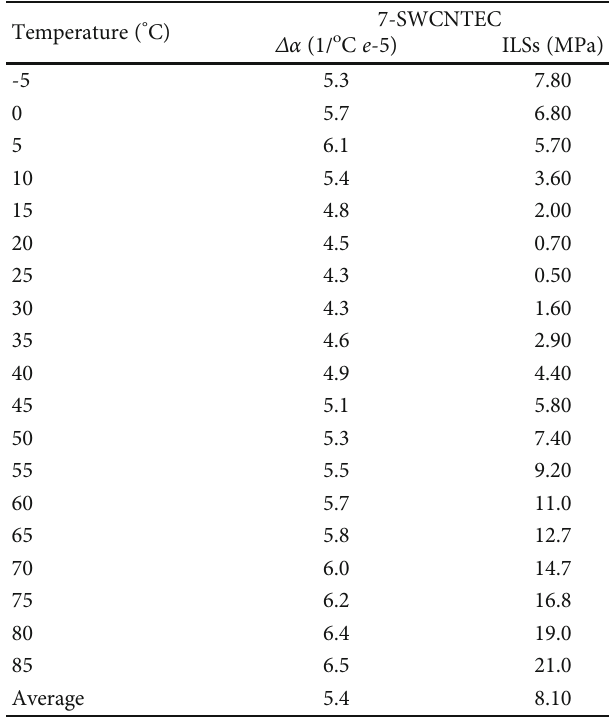
Table 5: Mismatches between the CTEs of 7-SWCNT and epoxy ( Δα ) and ILSs at the temperature range of -5 to 85 ° C within the